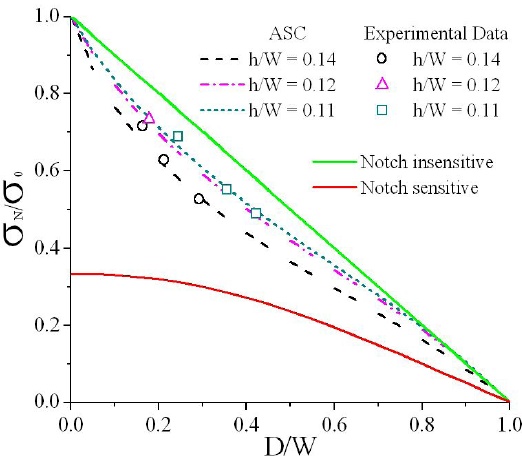
Figure 5. Comparison between the adapted ASC method proposed by Equation 18 and the experimental data.